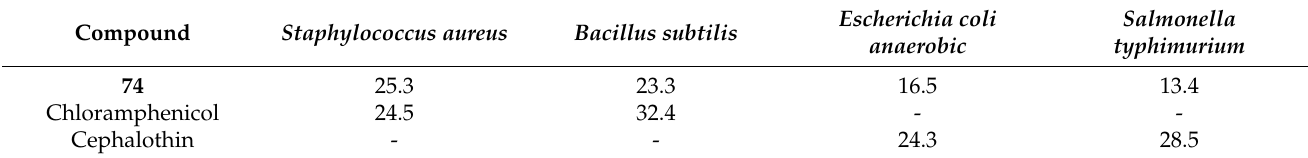
Table 6. Antibacterial activity of the compound 74 and the standards (MIC µ g mL − 1